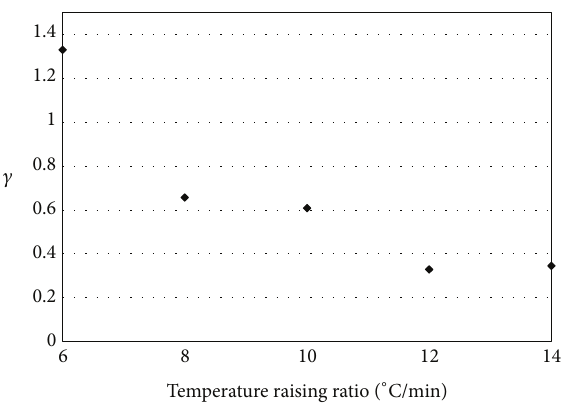
Figure 9: Activity coefficient of produced gas phase at different temperature raising